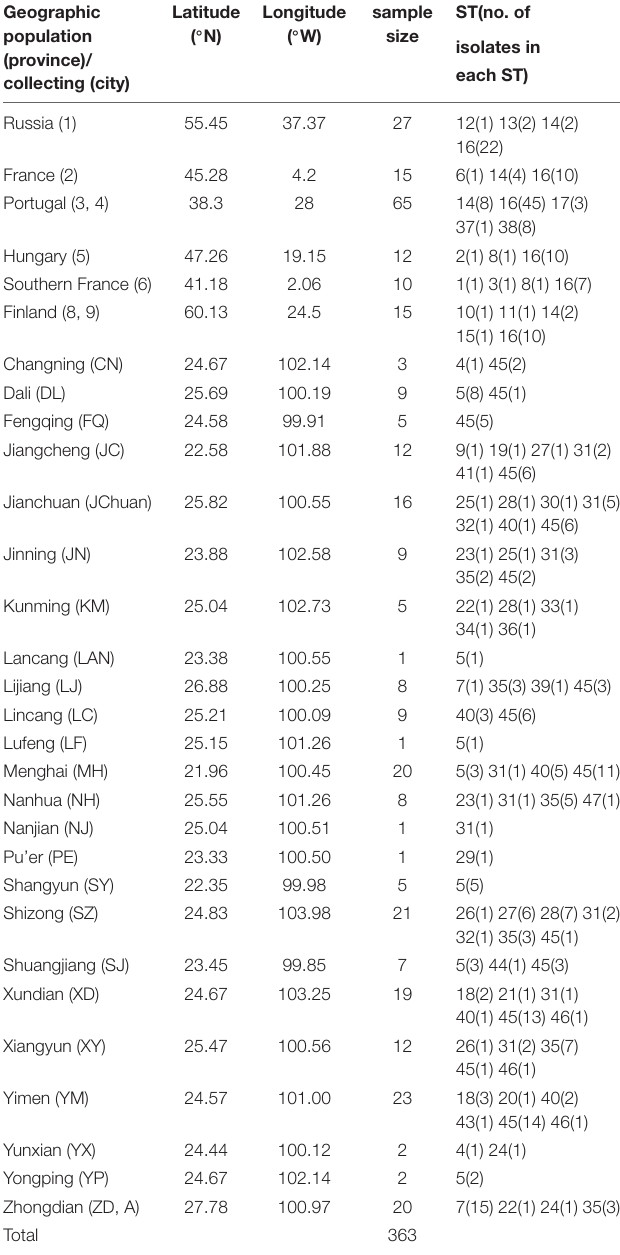
Latitude Longitude sample ST(no. of ( ◦ N) ( ◦ W) size isolates in each